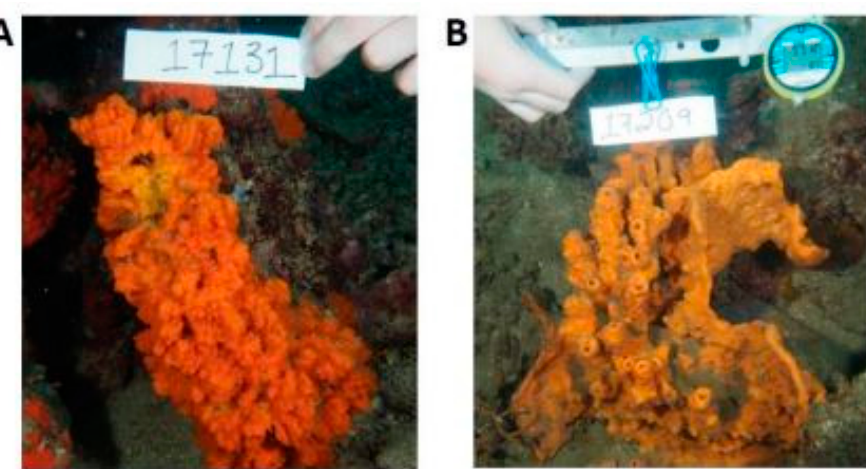
Figure 4. Two examples of species of the genus Jaspis. ( A ) Jaspis coriacea (Carter, 1886) and ( B ) Jaspis splendens (de Laubenfels, 1954) [41].